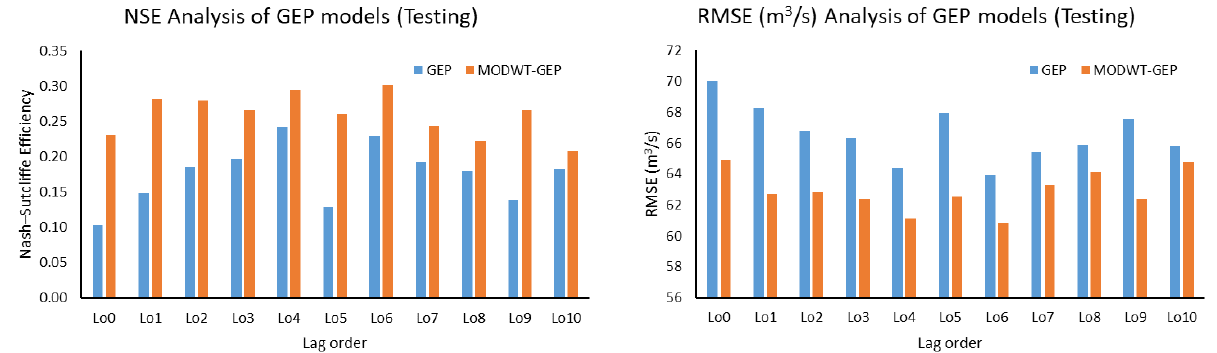
Figure 12. Performance evaluation of the GEP and MODWT-GEP models.